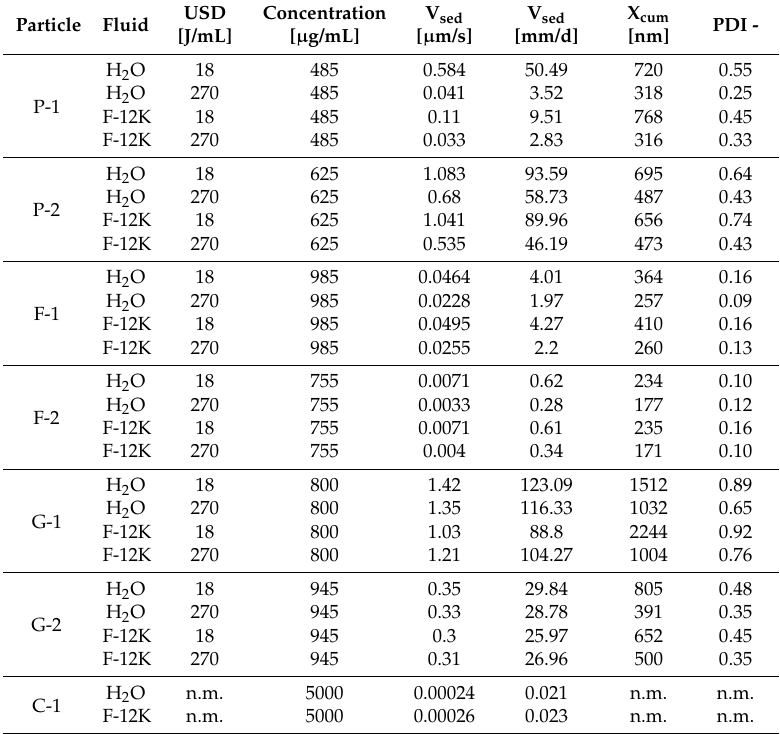
Table 4. Sedimentation, size and polydispersity index of selected SAS in H 2 O and F-12K medium. Particle